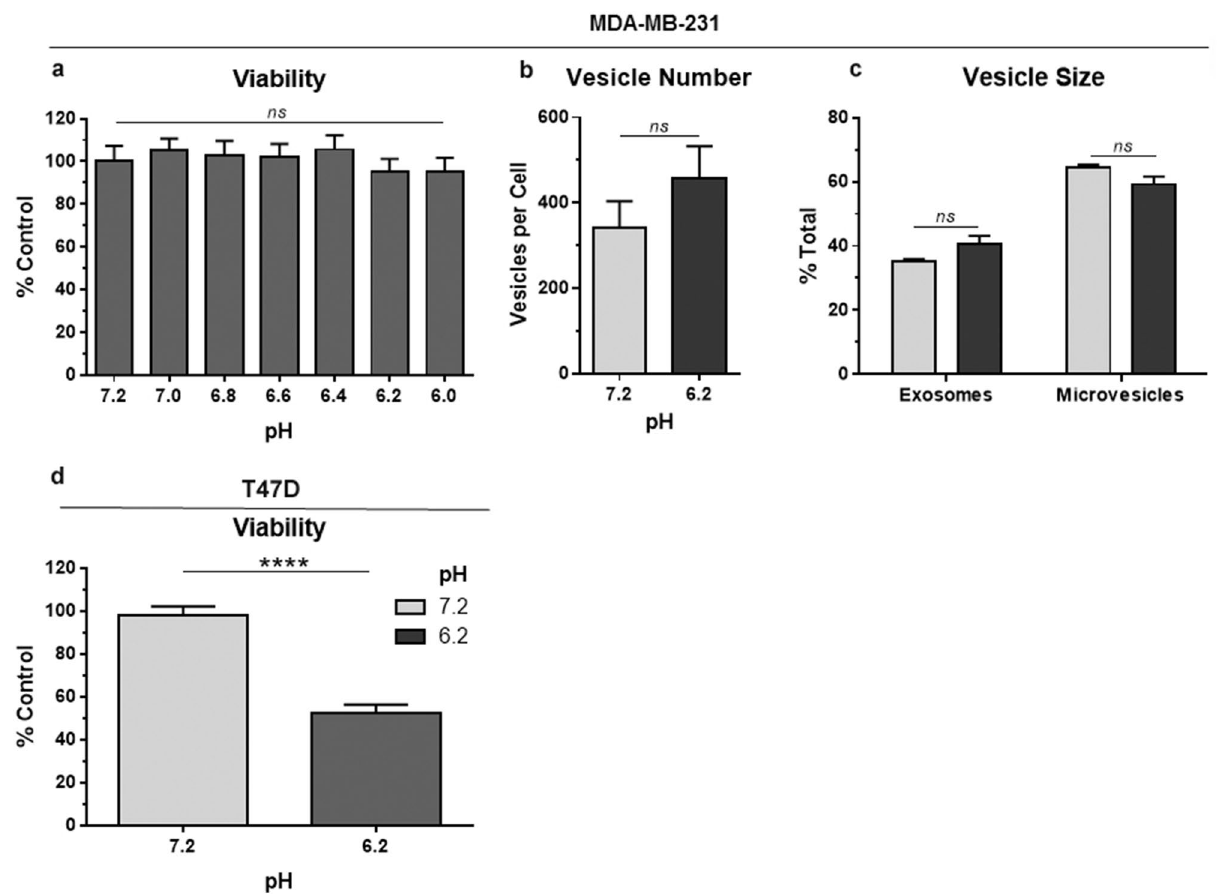
Figure 7. Acidic pH does not significantly affect MDA-MB-231 mammary carcinoma cell viability or extracellular vesicle production. ( a ) Viability of MDA-MB-231 or ( d ) T-47D cells was examined by MTT assay after 24 h growth at indicated pH. Data are shown as percent of control cells grown at pH 7.2 (mean + SEM, n = 8). ( b ) Extracellular vesicles produced by MDA-MB-231 cells cultured for 24 h at pH 7.2 or 6.2 were analyzed by NanoSight tracking analysis and shown as vesicles per cell (mean + SEM, n = 6). ( c ) Vesicle size was measured, grouped into exosomes (30–110 nm) or microvesicles (> 110 nm), and shown as percent of the total number of vesicles (mean + SEM, n = 3). ns indicates p > 0.05 as indicated by